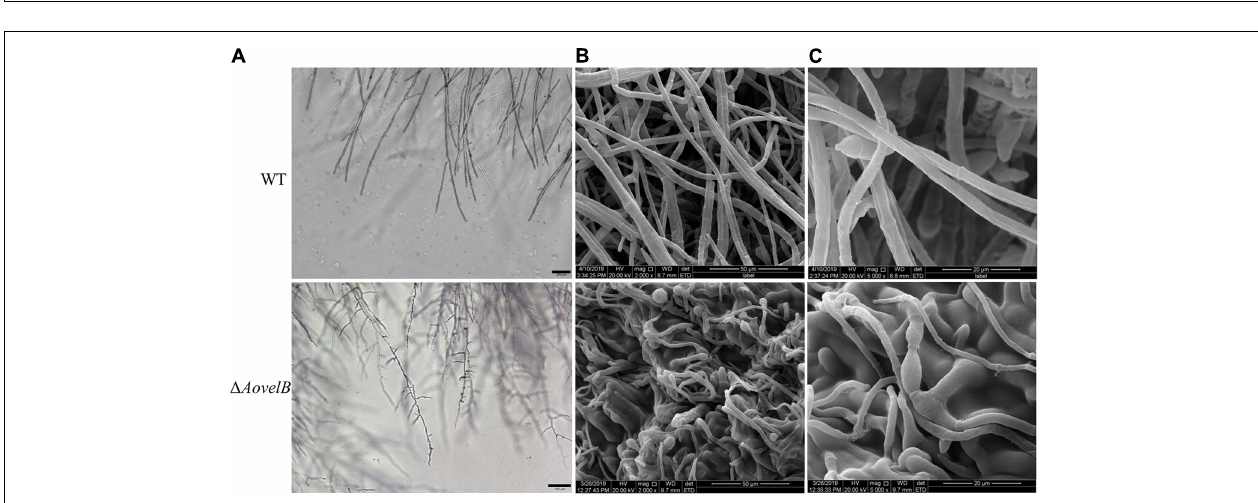
FIGURE 2 | Comparison of mycelial morphology between the wild type (WT) and mutant lines. WT and mutants were cultured for 7 days on CMY plates at 28 ◦ C. Mycelial samples were collected and treated as previously described (Kim et al., 2004). (A) Mycelial morphologies of the WT and (cid:49) AovelB mutants as observed by light microscopy. Bar: 100 µ m. (B,C) The WT strain and (cid:49) AovelB mutant were coated with gold and observed by scanning electron microscopy.